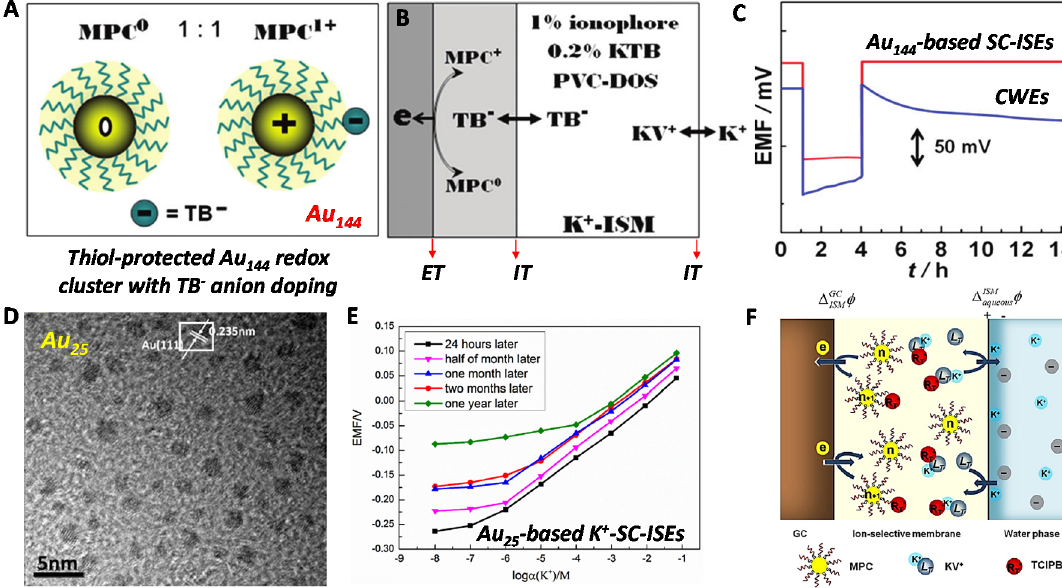
Figure 6. Au nanoclusters-based SC-ISEs. ( A – C ) Au 144 redox nanocluster based-SC-ISEs. ( A ) Reduced and oxidized states of thiol monolayer-protected Au clusters (MPCs) (Au 144 ) doped with tetrakis(4-chlorophenyl) borate (TB − ) anion (MPC 0 / MPC + TB − ). ( B ) Au MPCs-based SC-ISEs with well-defined phase interfacial potential definition. ( C ) Water-layer test of Au 144 -based SC-ISEs. Reprinted with permission from [61], Copyright (2012) American Chemical Society. ( D , E ) Au 25 redox nanocluster based-SC-ISEs. ( D ) Transmission electronic image (TEM) of the Au 25 synthesized by optimized one-phase reduction procedure. ( E ) The Au 25 -based SC-ISEs for K + -response to examine its long-term stability. Reprinted with permission from [62], Copyright (2016) Elsevier. ( F ) Au MPCs-based single-piece SC-ISEs through mixing the SC and ISM phase. Reprinted with permission from [63], Copyright (2016) Elsevier.